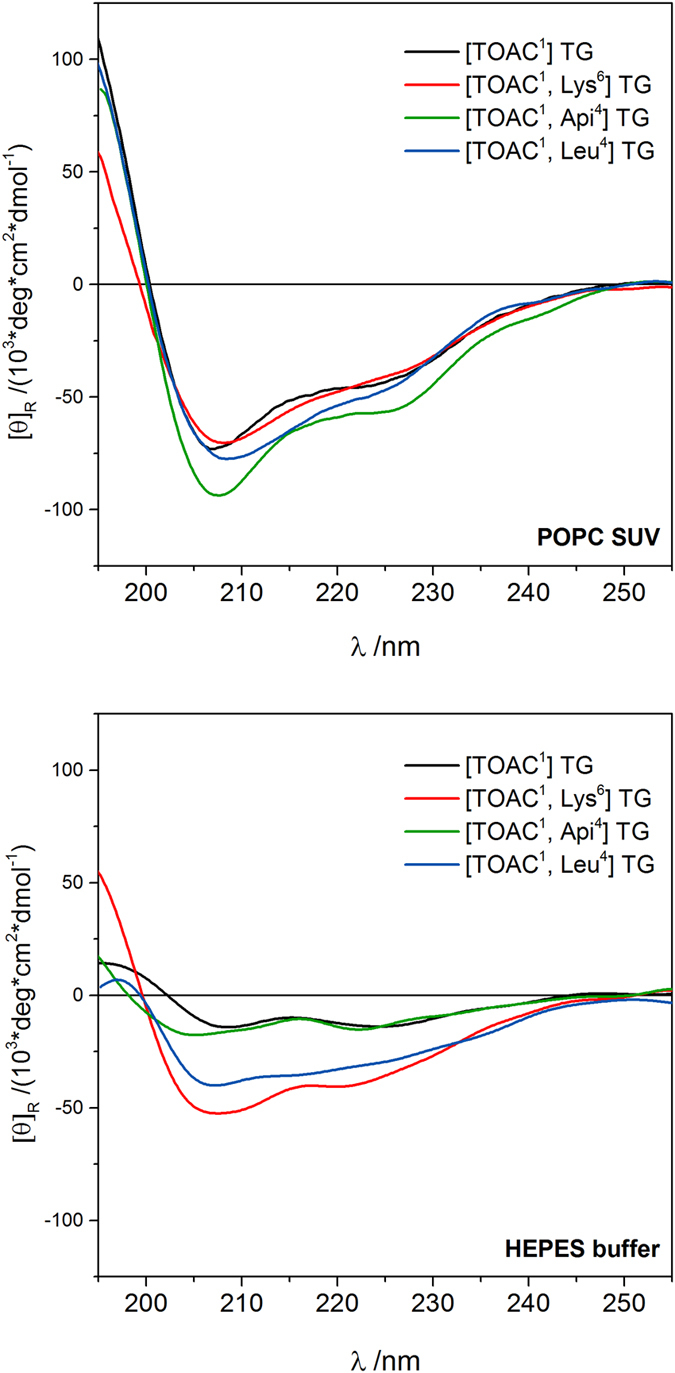
Far-UV/CD spectra of [TOAC1] TG, [TOAC1, Api4] TG, [TOAC1, Lys6] TG and [TOAC1, Leu4] TG in 2 mM POPC SUV (top) and in buffer solution (bottom).Peptide concentration, 0.1 mM.